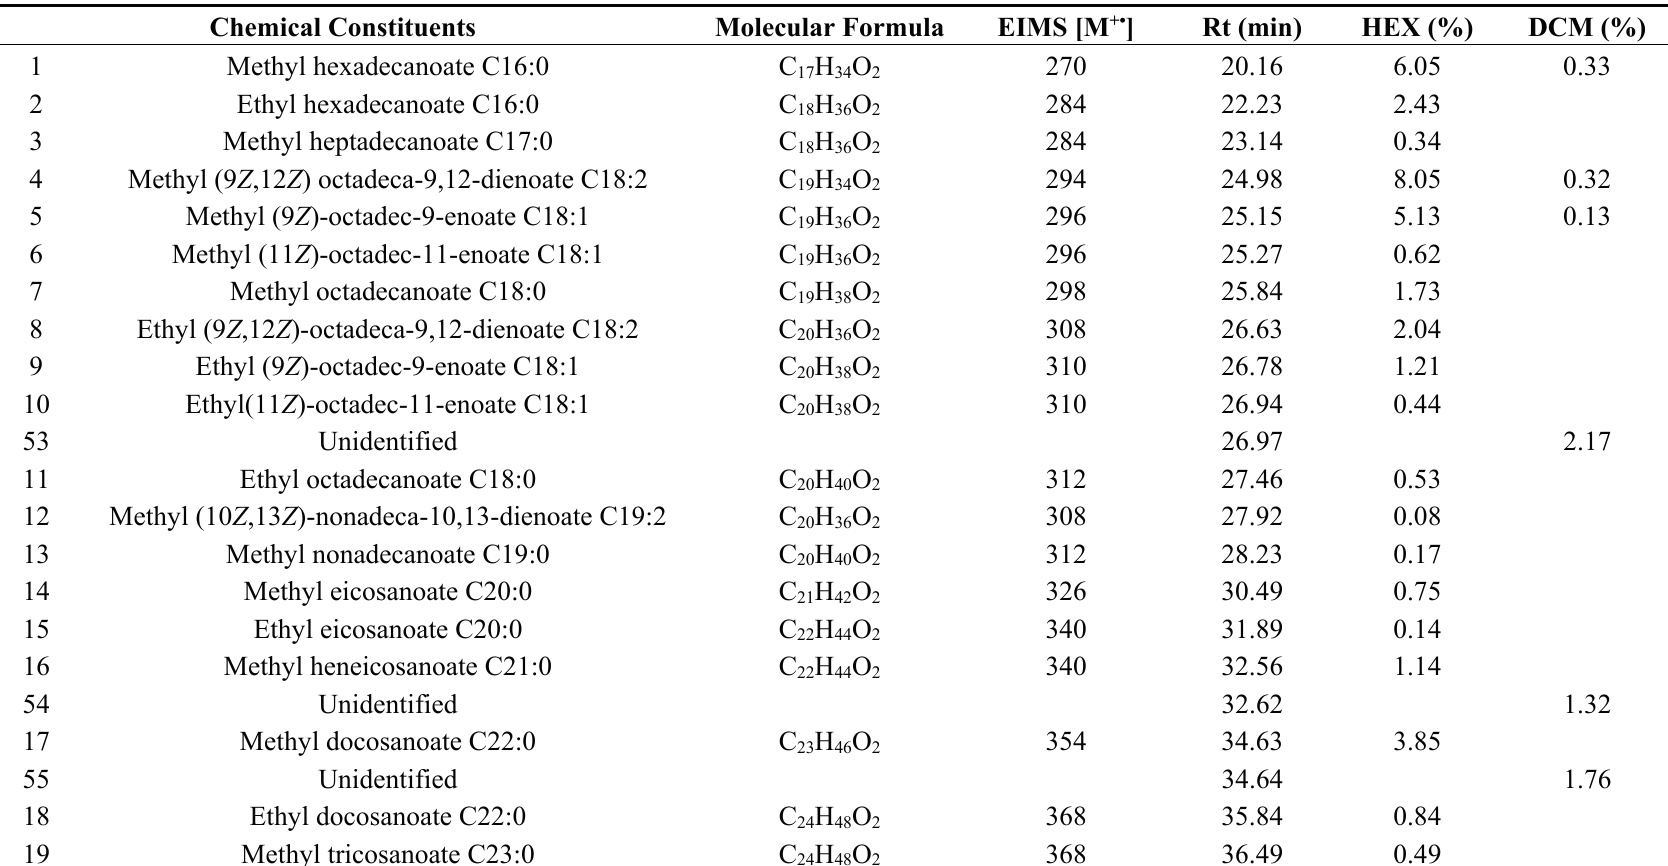
Table 1. Chemical compounds (%) identified by GC-qMS analysis of hexane and dichloromethane fractions of ethanolic stem bark extract of Mimosa caesalpiniifolia